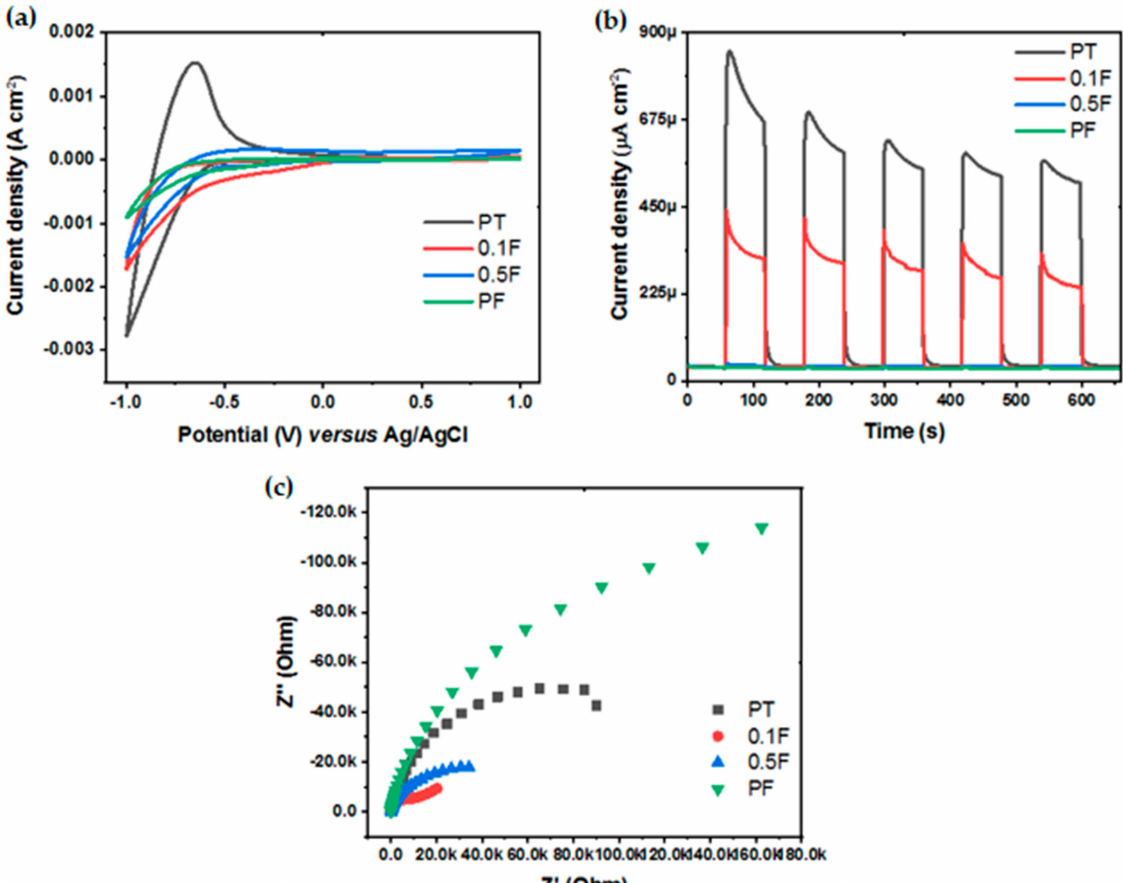
Figure 8. ( a ) Cyclic voltammetry profiles; ( b ) Transient photocurrent response ( I-t ) curves and ( c ) Nyquist plots of Electrochemical Impedance Spectroscopy (EIS) data for PT, 0.1F, 0.5F, and PF